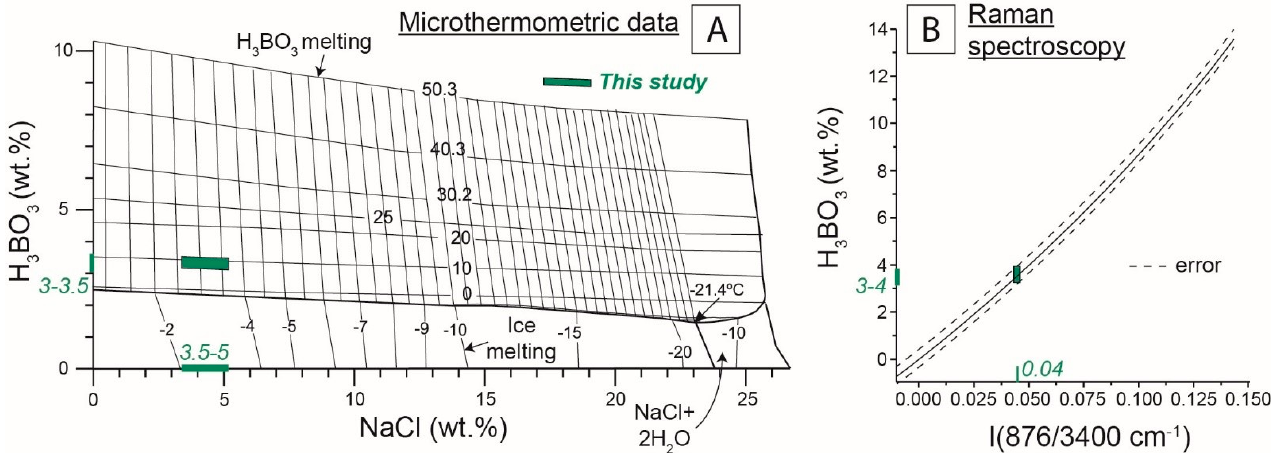
Figure 4. Boron and salinity concentration calculations. ( A ) Calculations from microthermometric results (Tm ice and T sas dissolution temperatures; Table S1), from the solubility diagram of [1] in the H 2 O-NaCl-H 3 BO 3 system. ( B ) Calculation from the correlation between Raman spectroscopy intensity ratio of the boron and H 2 O species bands and H 3 BO 3 concentration according to [52]. A recent third method was proposed by [53] and considers the correlation between salinity, boron concentration and Raman spectroscopy peaks. The use of this method in- dicates a salinity lower than 5 wt. % NaCl, consistent with the microthermometry calcu-